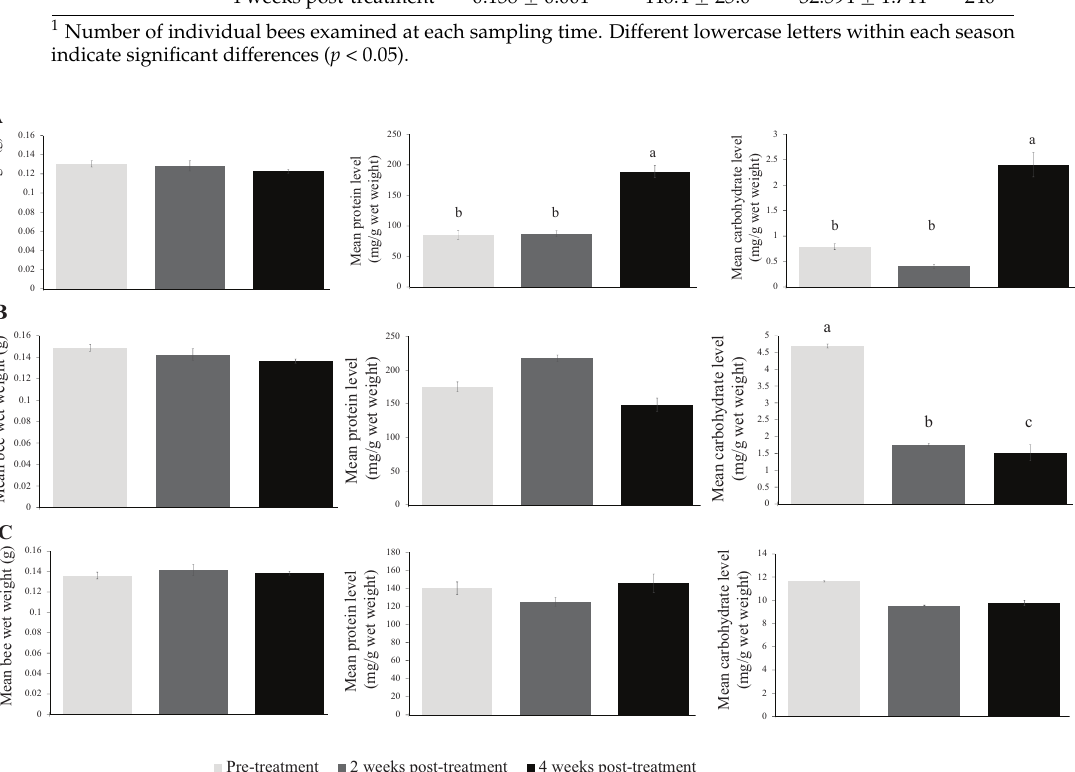
5 of 8 Table 2. Mean (±standard error) wet weight and macromolecule levels combined across four